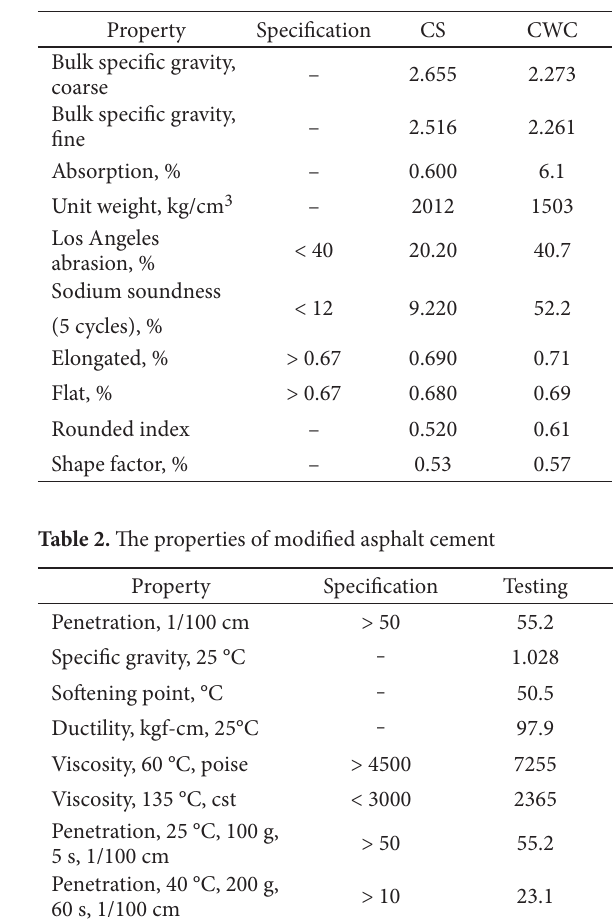
Table 1. Th e properties of CWC and CS